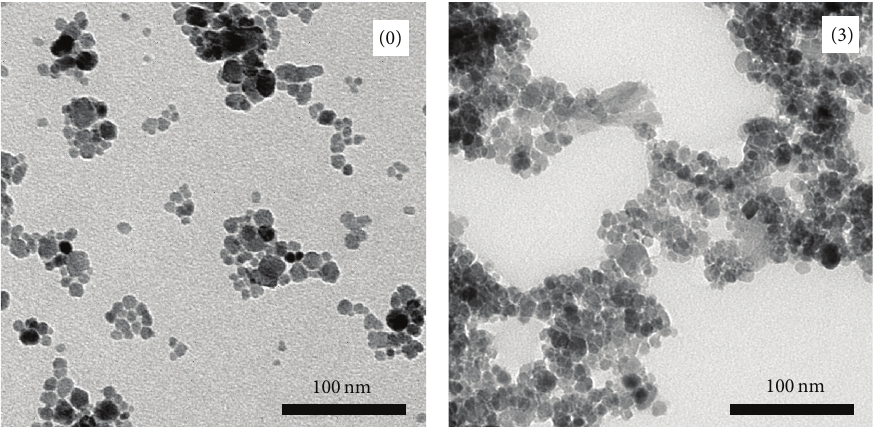
Figure 5: Typical TEM images for samples ( 0 ) and ( 3 ). Table 2: Binding energies (eV) of elements, determined from XPS measurements performed on samples ( 0 ) and ( 3